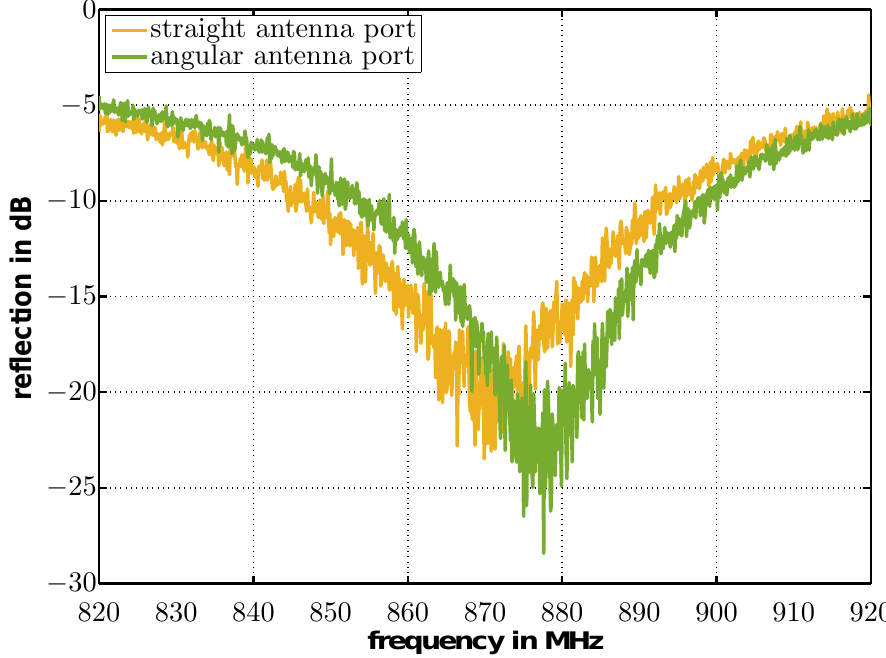
Figure 8. Reflections measured at the straight (yellow) and angular (green) antenna input ports over